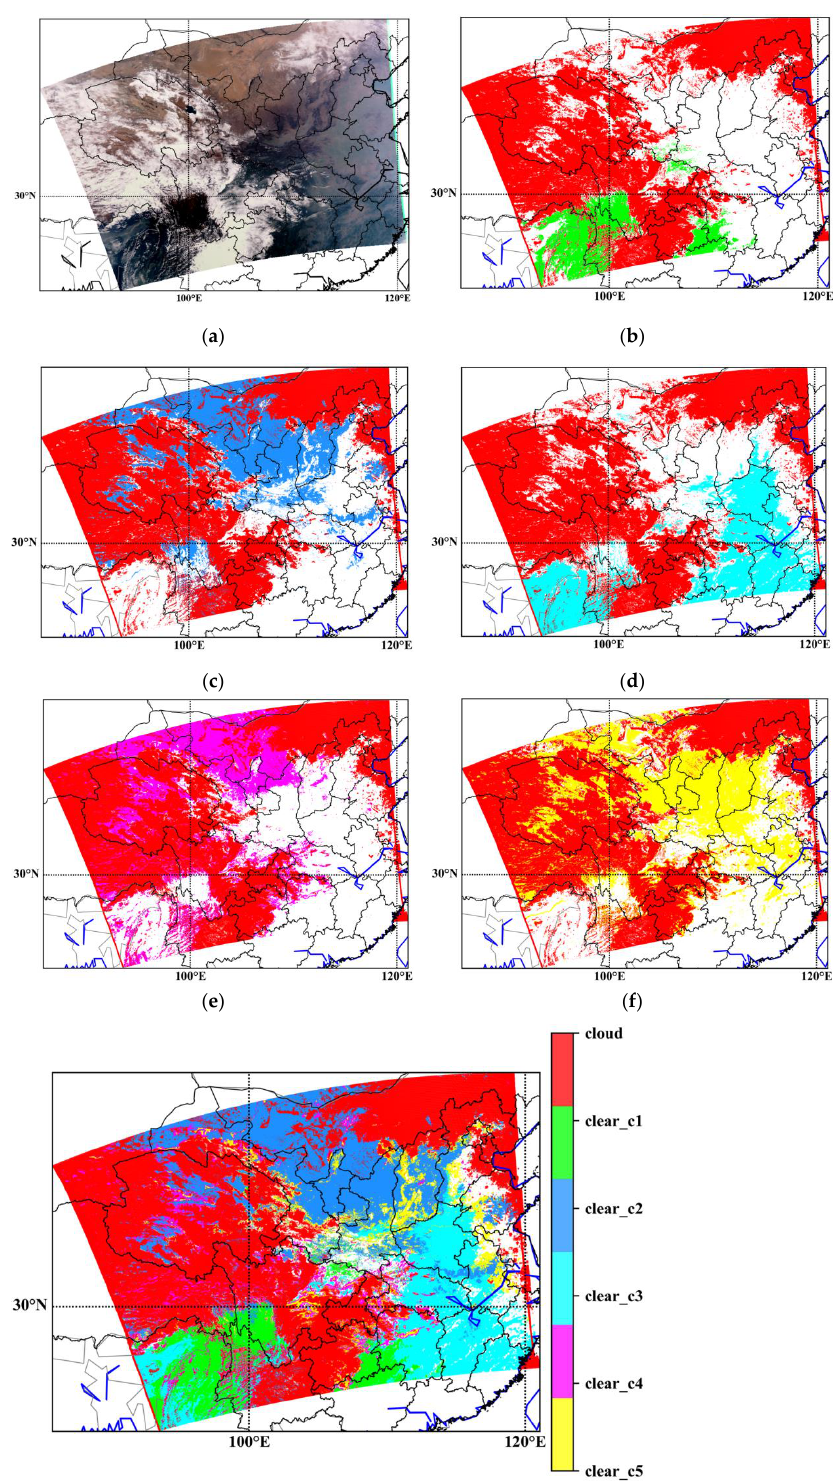
Figure 7. Test of clear detection conditions at UTC0605 on 3 December 2019. ( a ) A true color map. ( b ) The cloudy region was detected by three cloud conditions and the first clear condition, ( c ) the clear pixels were detected by clear condition 2, ( d ) the clear pixels were detected by clear condition 3, ( e ) the clear pixels were detected by clear condition 4, ( f ) the clear pixels were detected by clear condition 5 and ( g ) the final cloudy regions and clear pixels were detected by three cloudy conditions and five clear conditions.